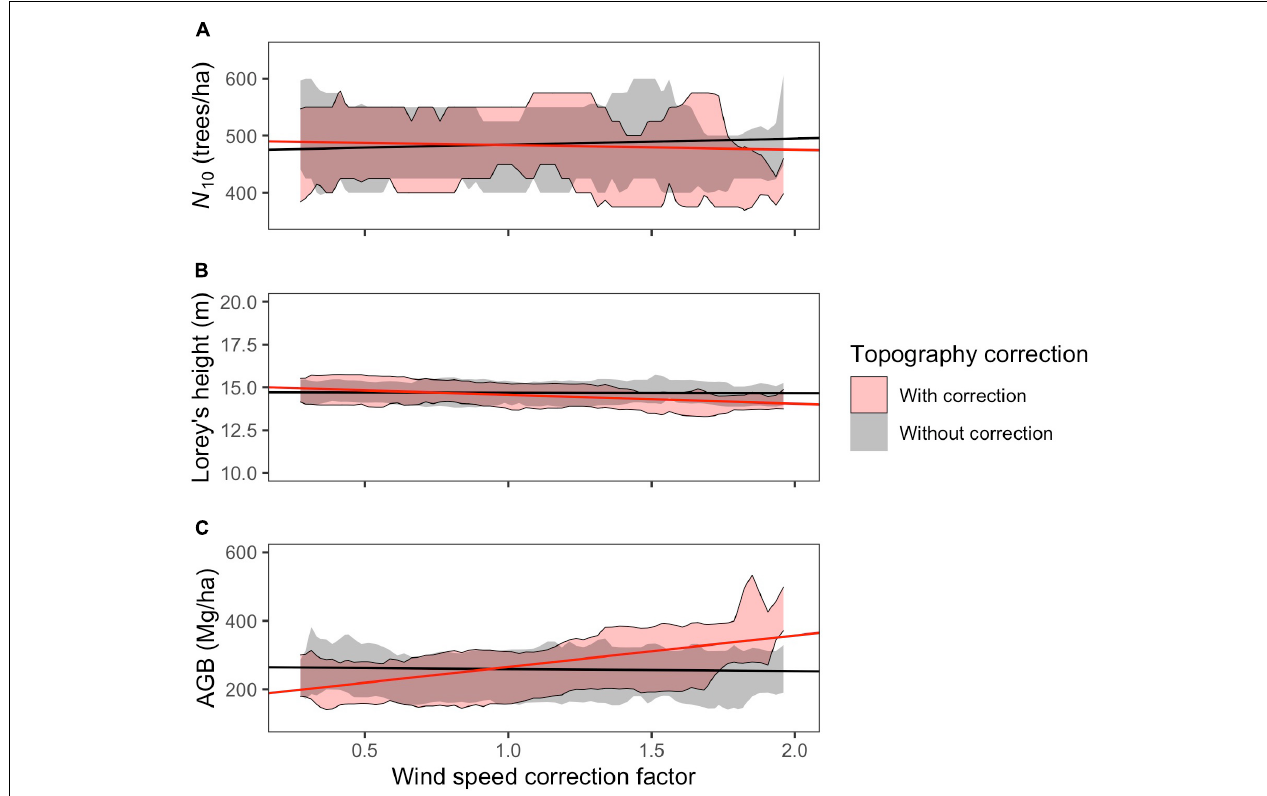
FIGURE 4 | Simulated quadrat-level forest structure statistics as a function of the topography-related wind speed correction factor of each quadrat. A correction factor > 1 means that the quadrat-level wind speed is accelerated„ and a correction factor < 1 means that the quadrat-level wind speed is decelerated. Shaded areas represent interquartile ranges (IQR), calculated within a moving window frame (0.025) across the whole x -axis value range and then linearly interpolated to the x -axis value at each quadrat. Black without border: without topography correction. Red with border: with topography correction. Solid lines represent the linear